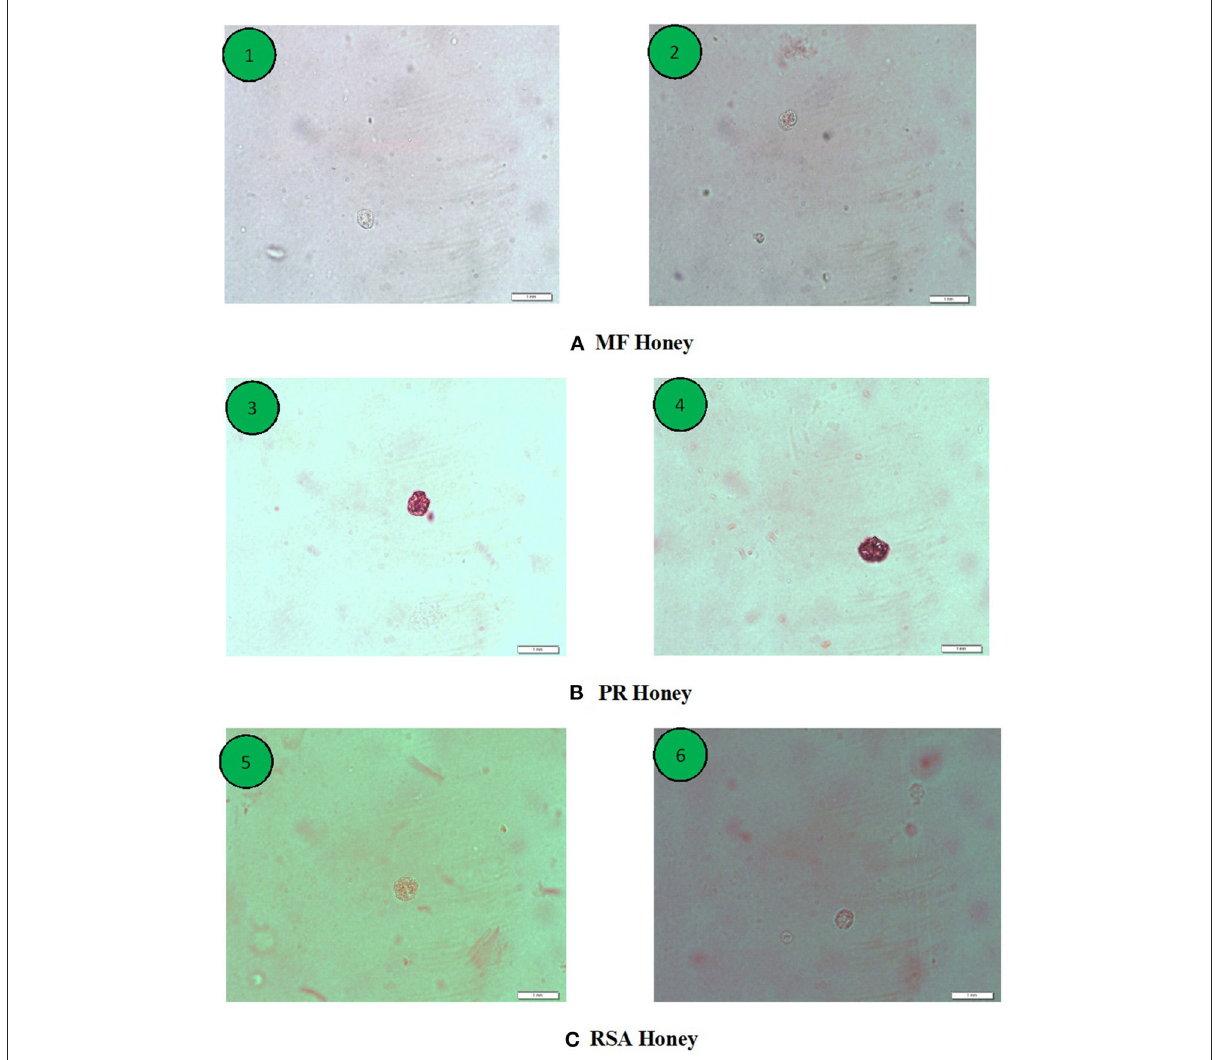
FIGURE3 Flow diagram showing the preparation of honey-based apple marmalade.